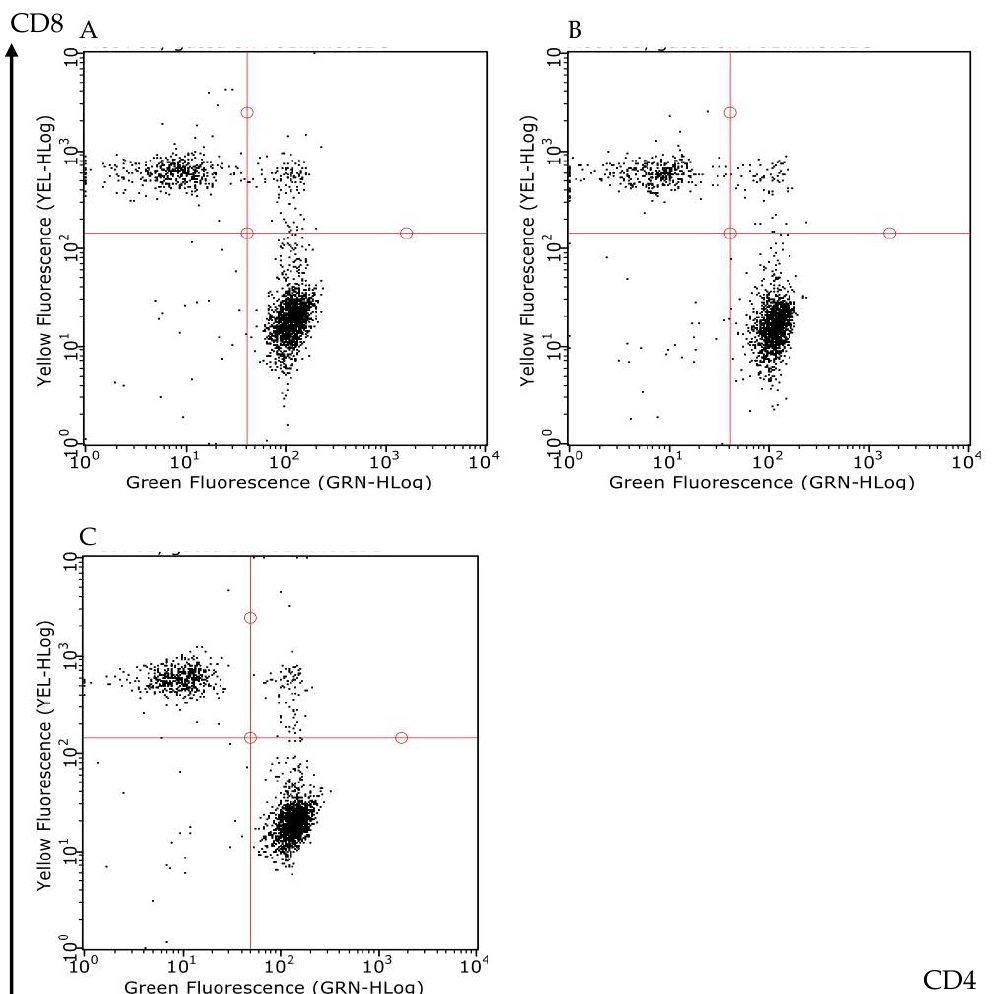
Figure 5. Effects of FTY720 on the T lymphocytes count in MLNs. Representative flow cytometry dot plots showing CD4 + CD8- (lower-right corner) and CD4-CD8 + (upper-left corner) T lymphocytes of MLNs excised from S mice ( A ) and I/R mice administered with vehicle ( B ) or with FTY720 3 mg/kg i.v. ( C ).